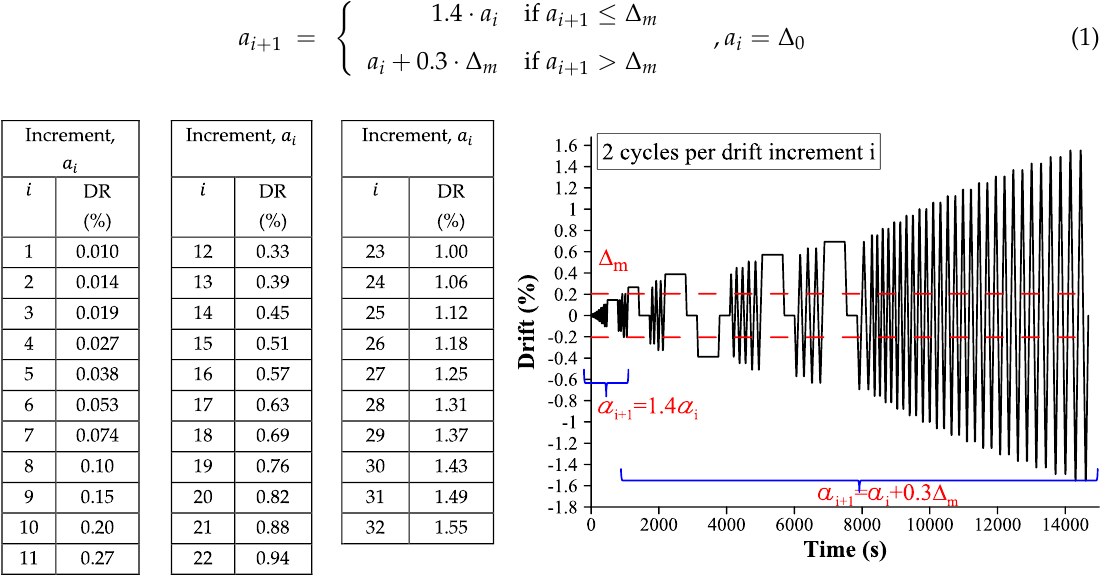
Figure 4. Drift protocol employed in